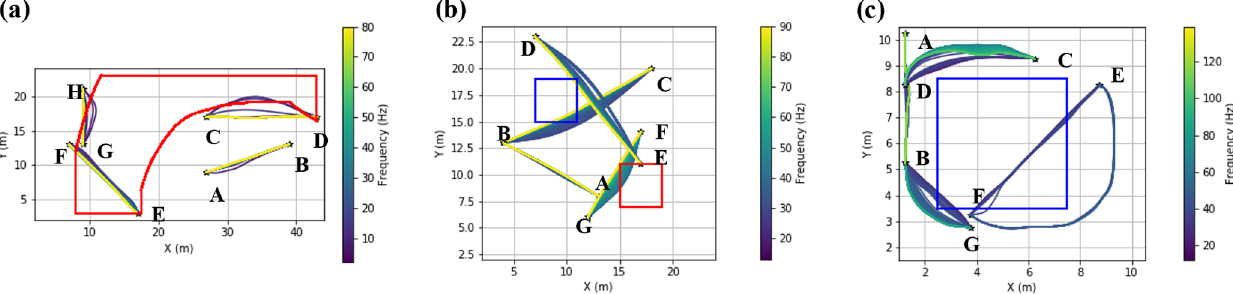
Figure 14. Examples of the computed ray paths at the last iteration of the curved-ray SWT inversion for (a) the sand bar model, (b) the Blocky model and (c) the CNR field. The boundaries of the low-velocity and high-velocity anomalies are shown in blue and red, respectively. The receiver locations are labelled as A–H.